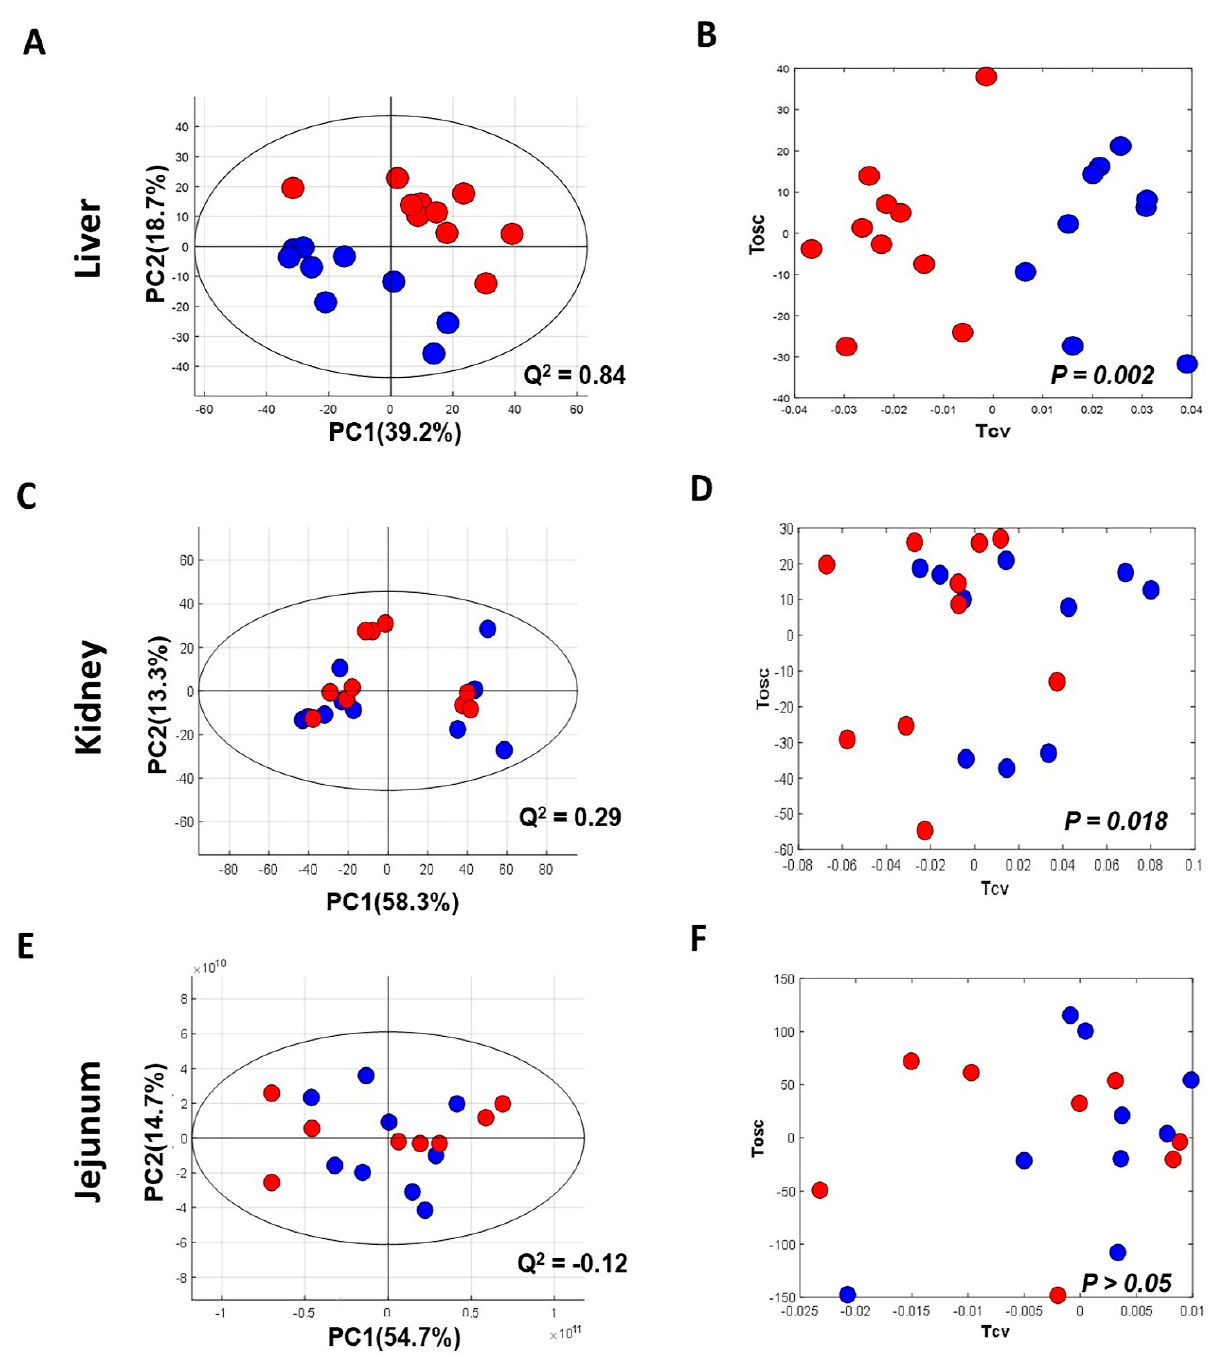
Figure 2. Principal component analysis (left panel) and O-PLS-DA score plot (right panel) of tissues of MSG-treated (Red) and control groups (Blue). ( A , B ) Liver; ( C , D ) kidney; and ( E , F ) jejunum.% PC represents variation explained by each principal component and Q 2 represents predictive ability of the model.